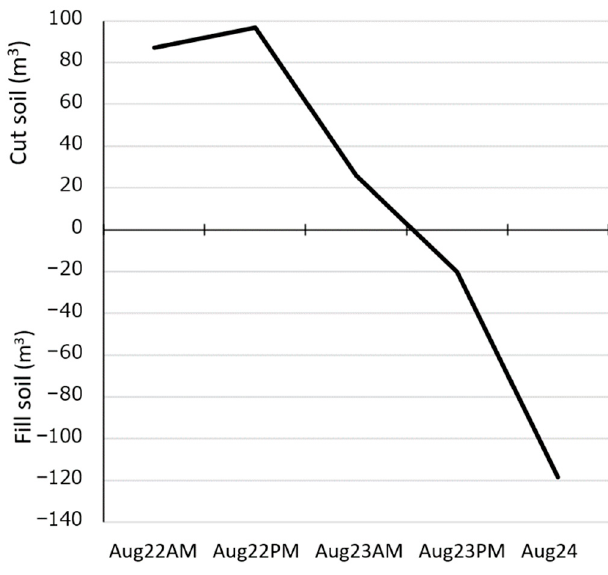
Figure 7. Cumulative amount of earthwork at each